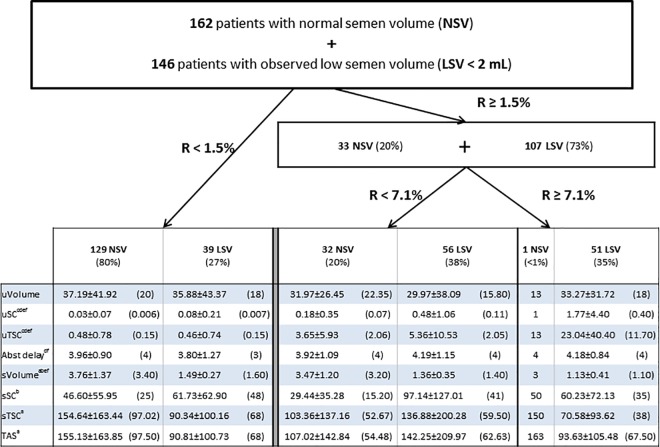
Semen and post ejaculatory urine characteristics as function of the R-value thresholds obtained from the CART procedure in 162 patients with normal semen volume (NSV) and 146 patients with observed low semen volume < 2 mL (LSV).Values are mean ± SD (median); 1.5% and 7.1%, thresholds values of R determined by the CART procedure on the 308 (162 plus 146) patients; % corresponds to number of patients/total number of patients with NSV or LSV. Three ranges of R-value classified patients: 80% of NSV patients (129/162) and 27% of LSV patients (39/146) were under an R-value of 1.5%, 20% of NSV and 38% of LSV were comprised between 1.5% and 7.1%, and less than 1% of NSV and 35% of LSV had an R-value ≥ 7.1%. R (%), [uTSC divided by (uTSC plus sTSC)] multiplied by 100 uVolume, urine volume (ml) uSC, urine sperm count (106/ml) uTSC, urine total sperm count (uVolume multiplied by uSC; 106) Abst Delay, abstinence delay (days) sVolume, semen volume (ml) sSC, semen sperm count (106/ml) sTSC, semen total sperm count (sVolume multiplied by sSC; 106) TAS, total amount of sperm (uTSC plus sTSC; 106) a p < 0.05 between 129 NSV and 39 LSV b p < 0.05 between 32 NSV and 56 LSV c p < 0.05 between 129 NSV (R < 1.5%) and 32 NSV (1.5 ≤ R < 7.1%) d p < 0.05 between 39 LSV (R < 1.5%) and 56 LSV (1.5 ≤ R < 7.1%) e p < 0.05 between 56 LSV (1.5 ≤ R < 7.1%) and 51 LSV (R ≥ 7.1%) f p < 0.05 between 39 LSV (R < 1.5%) and 51 LSV (R ≥ 7.1%)